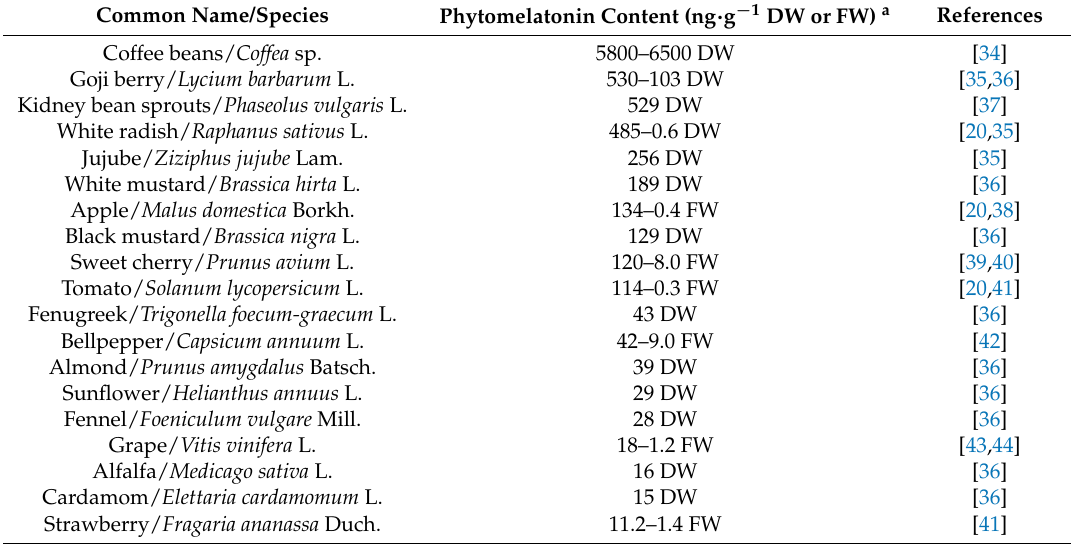
Table 1. Phytomelatonin content of some edible plant species.